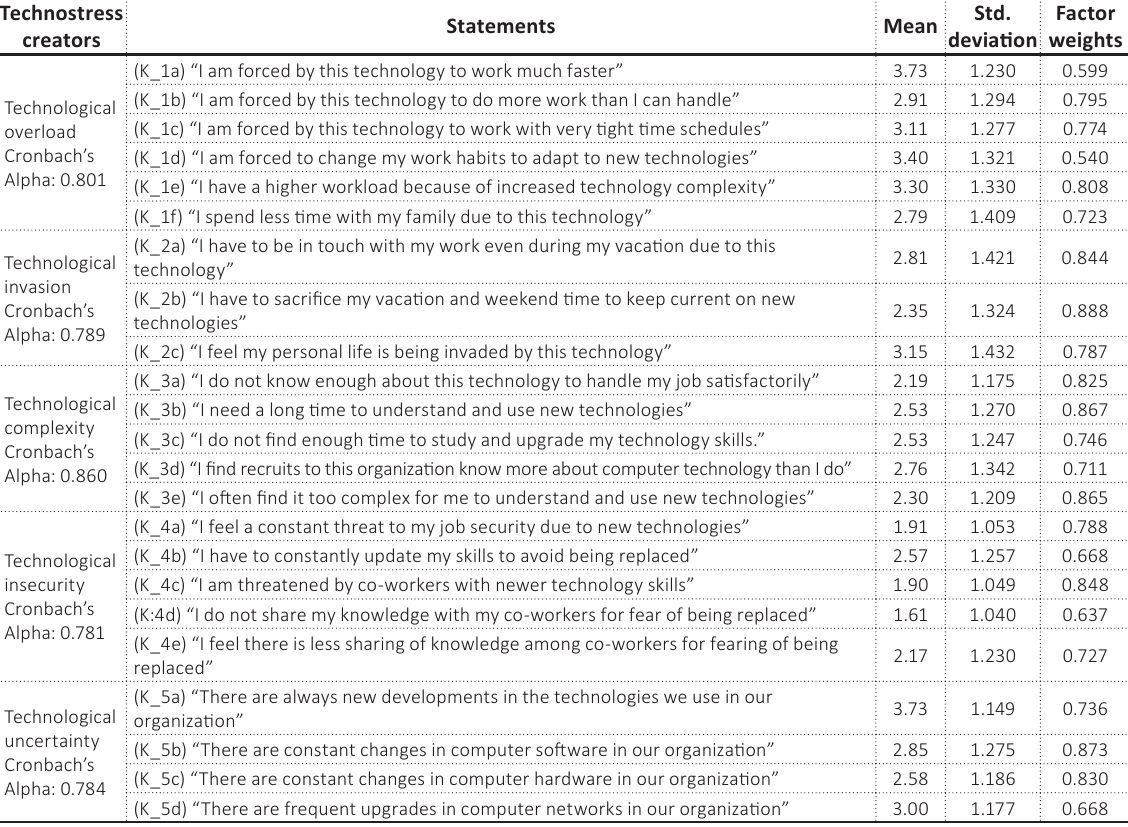
Table 4. Characteristics and effects of technostress (mean, standard deviation, factor